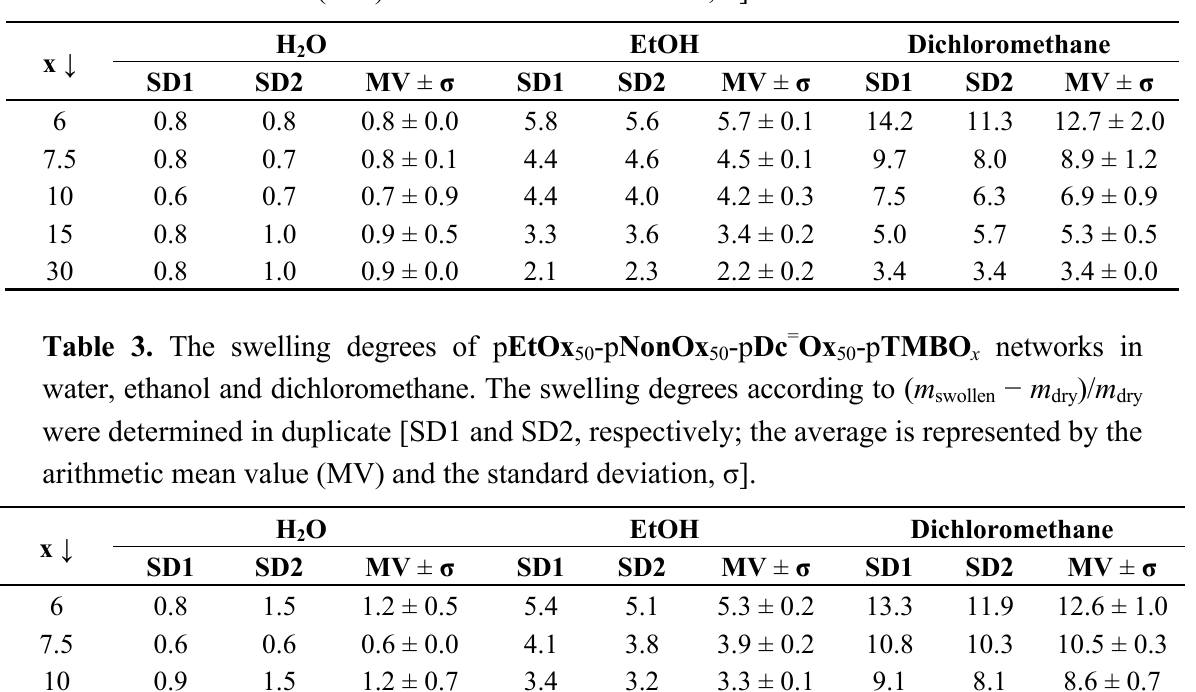
-p Dc = Ox -p TMBO networks in water, ethanol 100 50 x − m )/ m were swollen dry dry